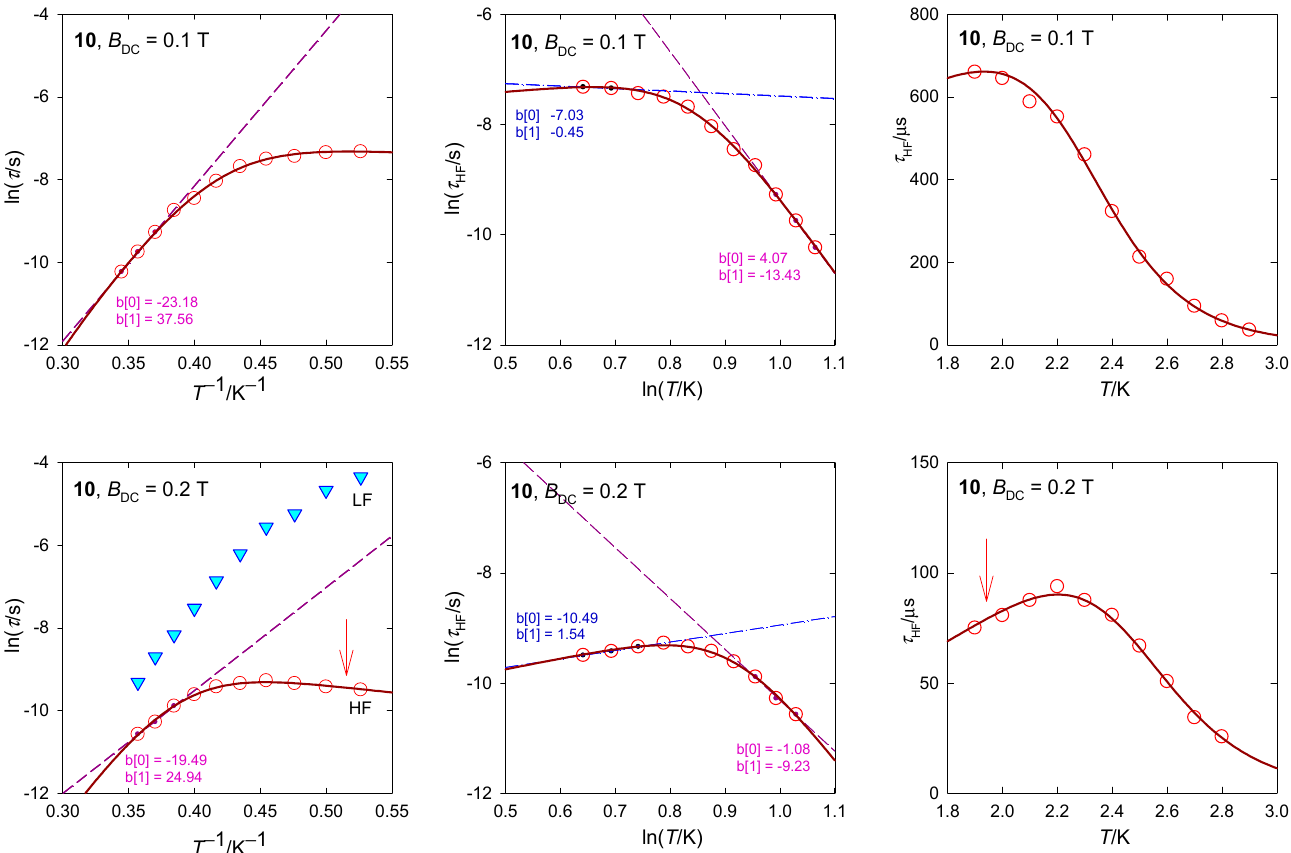
Figure 19. Various dependences of the high-frequency relaxation time in 10 . Dashed/dot-dashed—linear fits. Full line—fitted over the whole temperature range using τ − 1 = CT n + FT − k . An arrow indicates the RTB behavior.